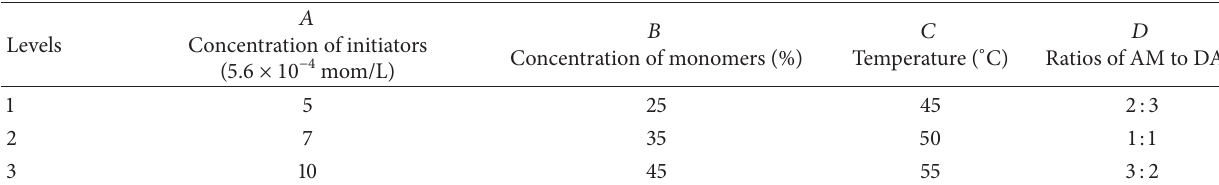
Table 1: Factors and levels.